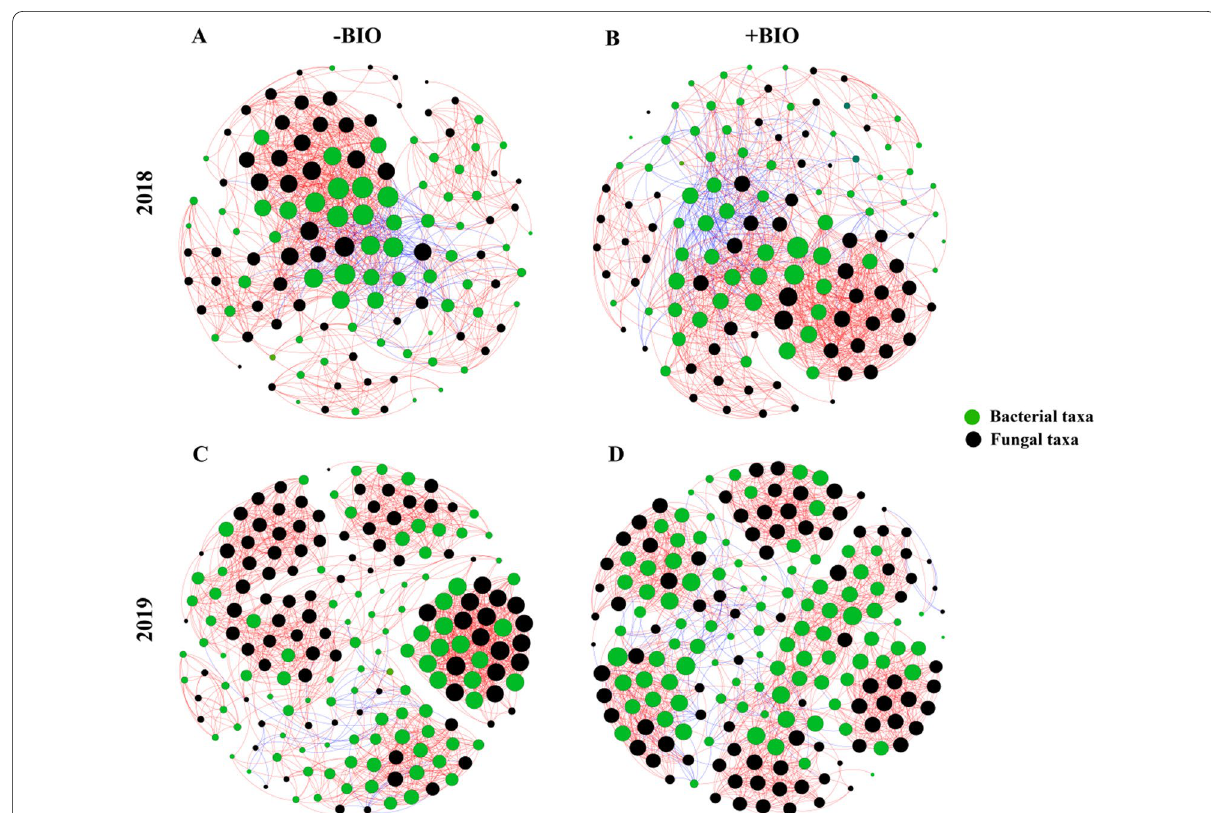
Fig. 5 Network analysis revealing the co-occurrence pattern between bacterial and fungal OTUs in -BIO (CK and CK-HA, A and C ) and and BIO-HA, B and D ) treated soils, 2018 and 2019. Green and black colored nodes signify corresponding OTUs assigned to bacterial and fungal major phyla, respectively. Red lines and blue lines represent strong positive linear (r > 0.6) and strong negative linear (r < respectively. The size of each node is proportional to the number of connections